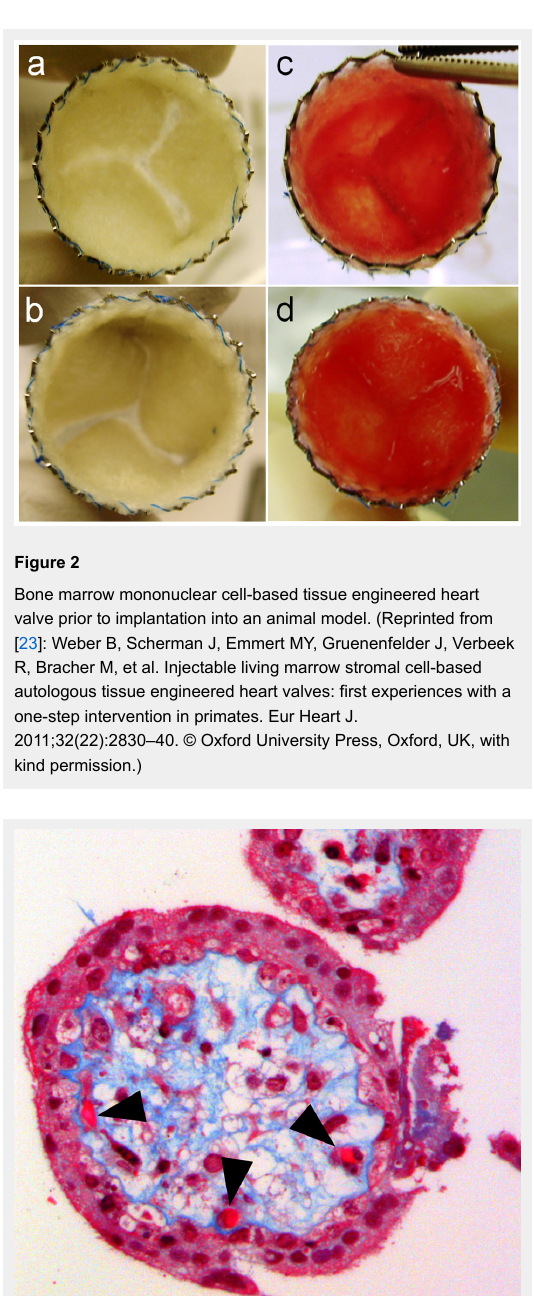
Human umbilical cord Wharton’s jelly-derived myofibroblast-like cells (WMFs) revealed smooth muscle-like phenotypes with positive stainings for vimentin (C), desmin (E) and partially for α-sma (A) similar to mature vascular-derived myofibroblasts (B, D, F). (Reprinted from [48]: Weber B, Schoenauer R, Papadopulos F, Modregger P, Peter S, Stampanoni M, et al. Engineering of living autologous human umbilical cord cell-based septal occluder membranes using composite PGA-P4HB matrices. Biomaterials. 2011;32(36):9630–41. © Elsevier, Oxford, UK, with kind